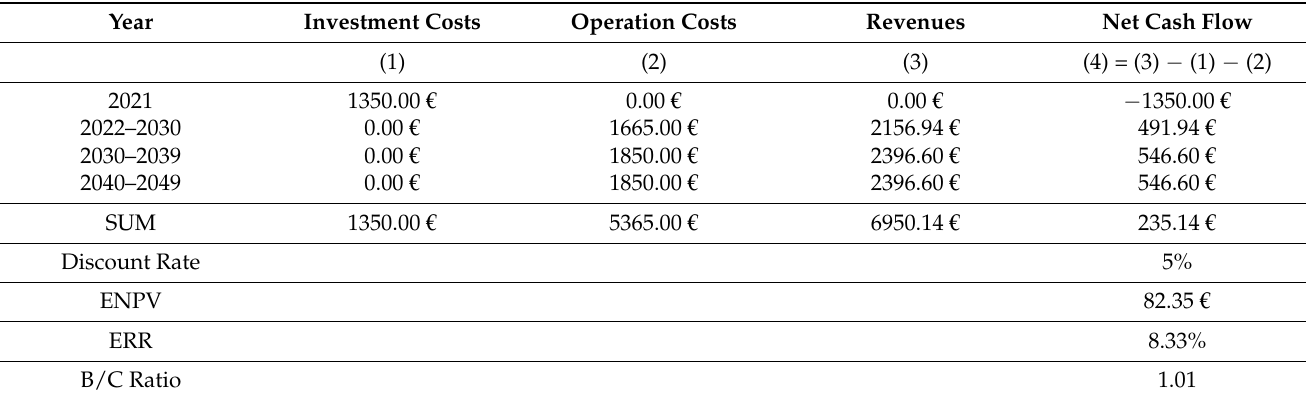
Table 8. Economic performance analysis and